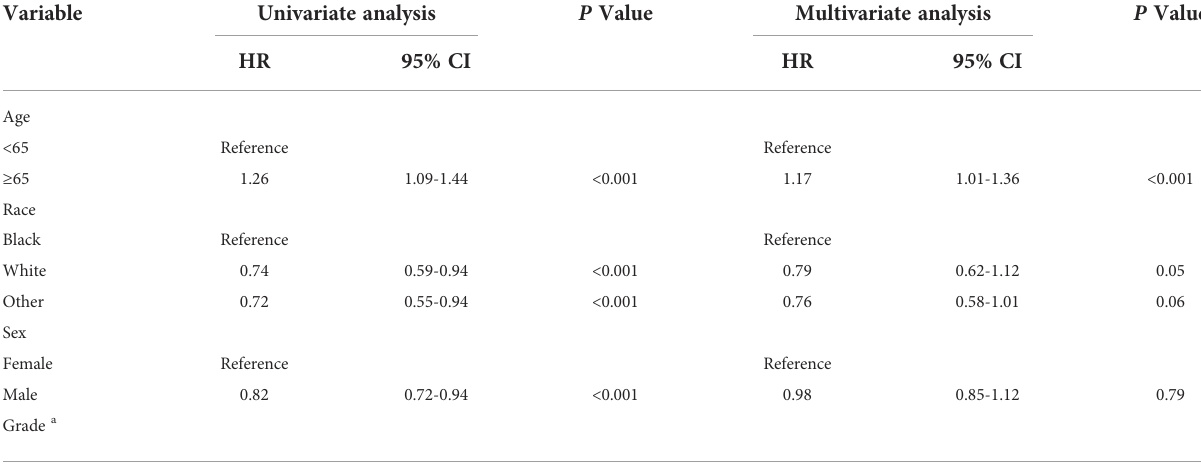
TABLE 2 The results of univariate and multivariate Cox regression analyses on variables for the prediction of